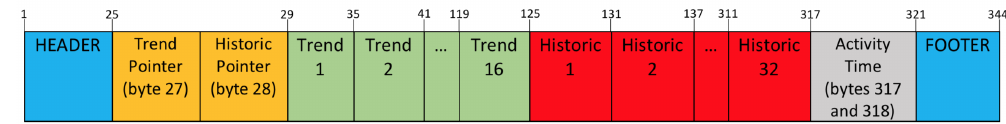
Figure 3. Structure of the internal memory (in byte) of Abbot’s Freestyle Libre